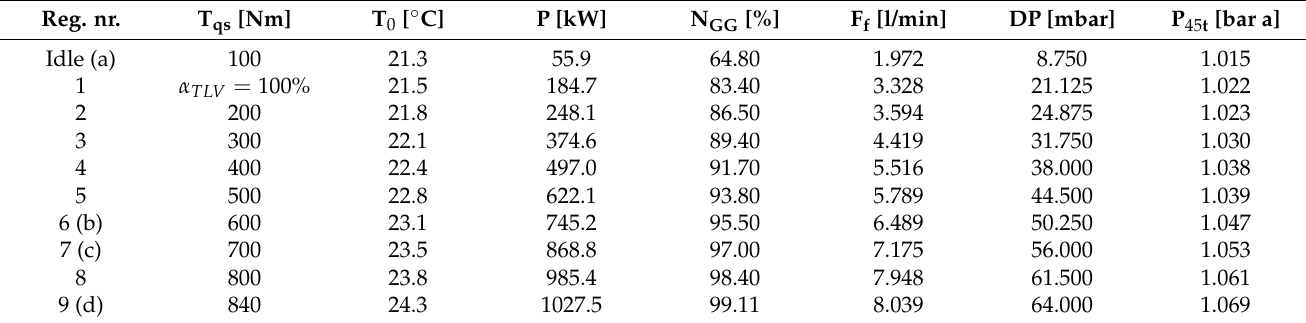
Table 3. Measured parameters at each engine working regime part two.